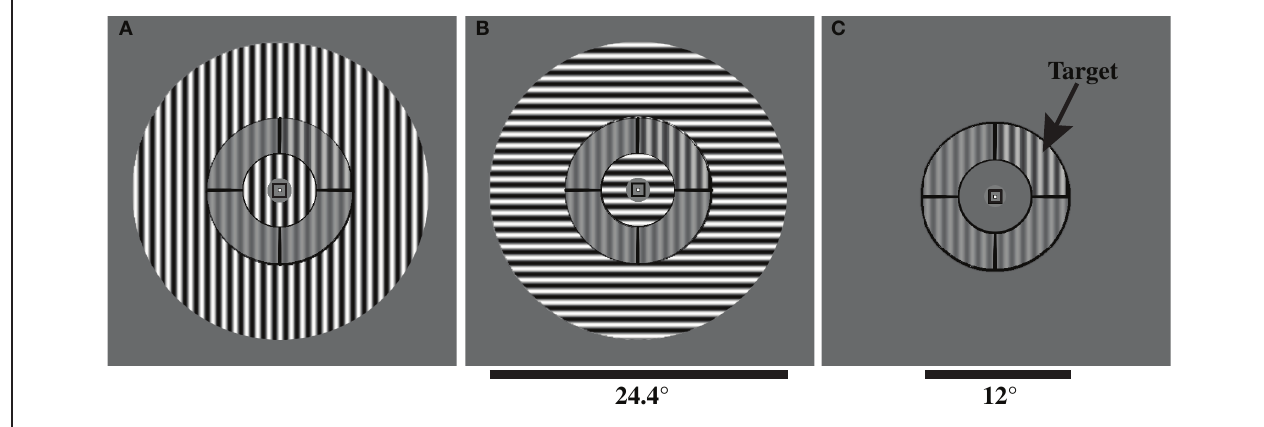
FIGURE 1 | Stimuli used to measure OSSS in Experiment 1. Subjects performed a contrast discrimination task in one of three surround conditions: (A) parallel surround (PS), (B) orthogonal surround (OS), and (C) no surround